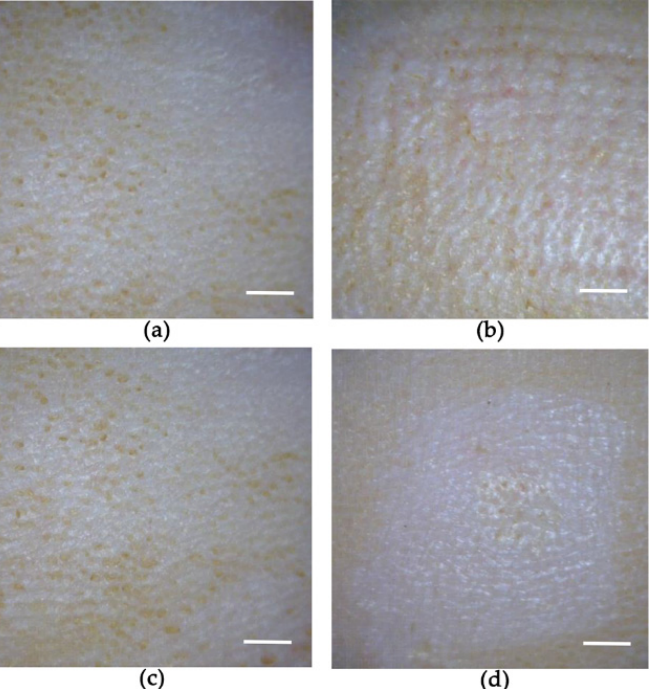
Figure 5. Absence of skin irritation following application of donepezil-loaded DMN patches: ( a ) before and ( b ) after 1 h application, and ( c ) before and ( d ) after 1 week application. The scale bars represent 2 mm.